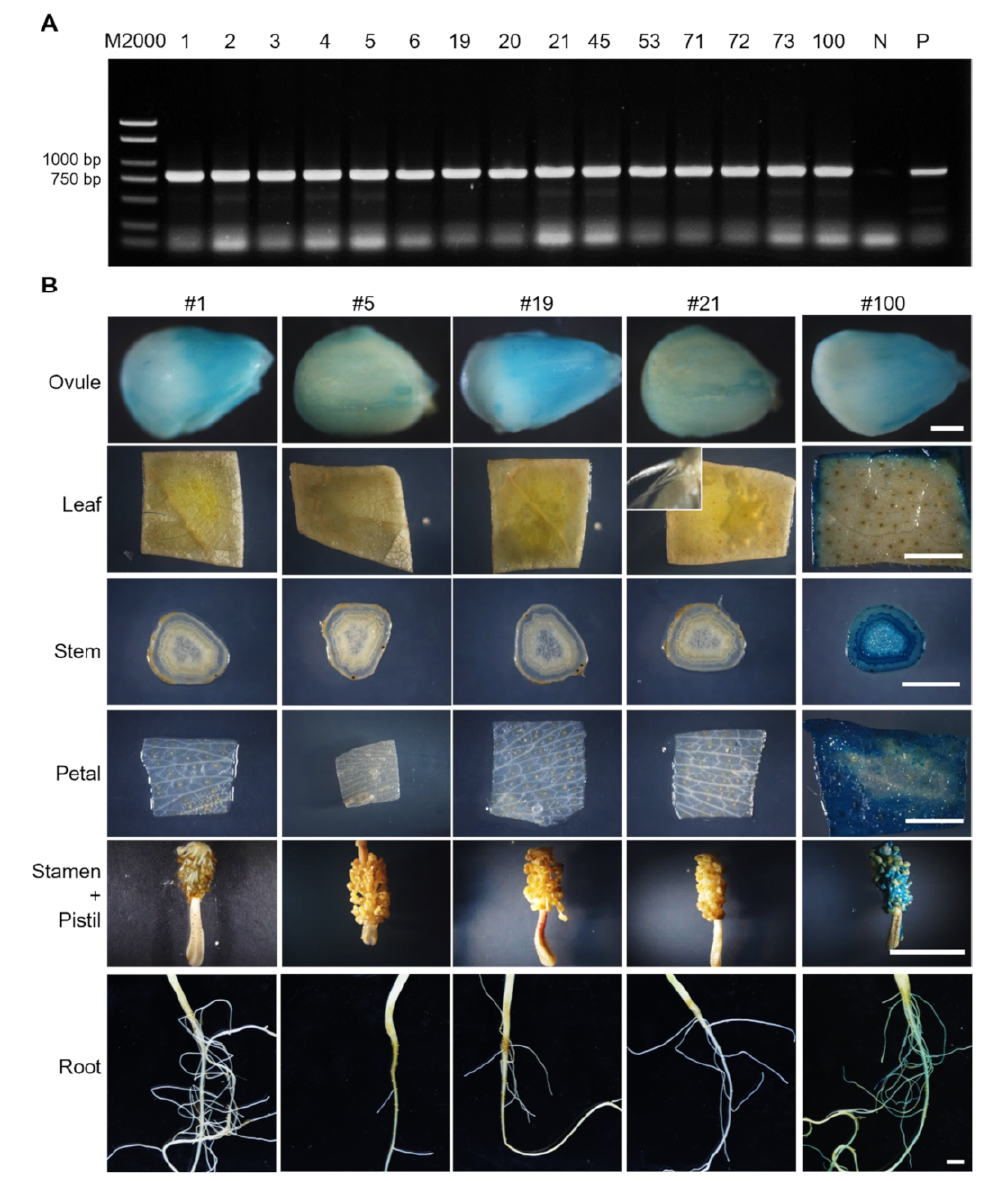
Figure 2. Identification of proGhROP6::GUS transgenic cotton. ( A ) PCR identification of introduction of selection gene NPTII . Number of transformants is shown in each lane. N represents the negative control. P represents the positive control of a NPTII -containing plasmid. ( B ) GUS staining in ovules, leaves, stems, petals, stamens, pistils, and roots. Floral organs were harvested at 0 DPA. The inset shows leaf trichomes. Scale bars represent 500 µ m (ovule images) or 5 mm (the